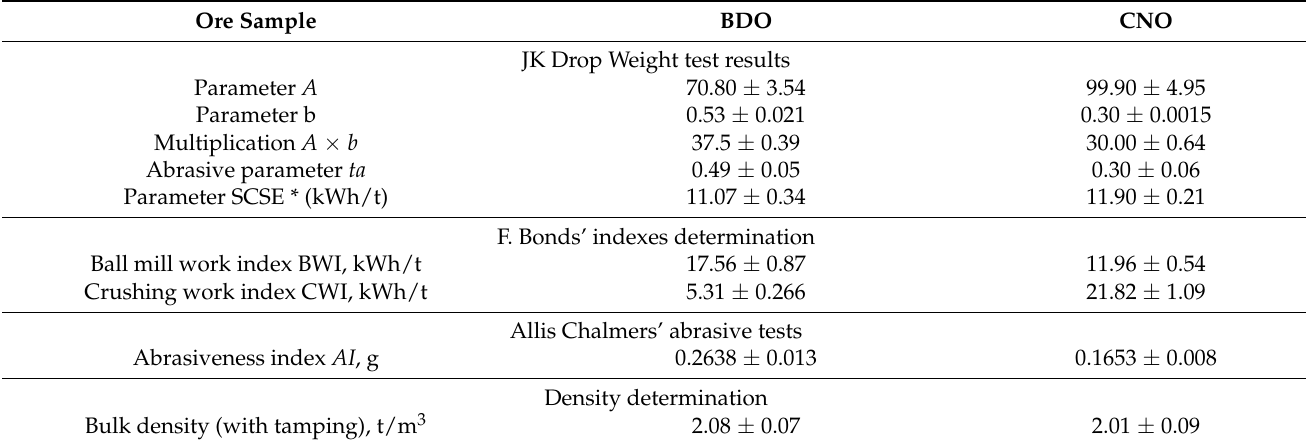
Table 6. Summary table of physical and mechanical properties of the investigated ore